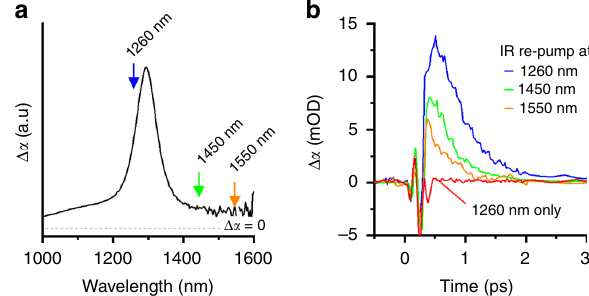
Fig. 6 Two-color pumping of colloidal quantum wells. a NIR-photoinduced absorption of a 5.5 ML CQW ensemble following 400 nm excitation at 50 ps delay. The gray dashed line indicates the position of zero change in absorption. b Transient dynamics probed at 560 nm) using an unchopped 400 nm excitation followed, at 50 ps, by chopped IR pump pulses of various indicated energies. The observed dynamics are those induced by the chopped IR pump pulses, which re-pump the already excited CQWs. The full-width at half-maximum of the ~30 fs pump pulses is ~100 meV. Excitation at 1260nm in the absence of the unchopped 400 nm excitation (shown in red) yields only a transient Stark